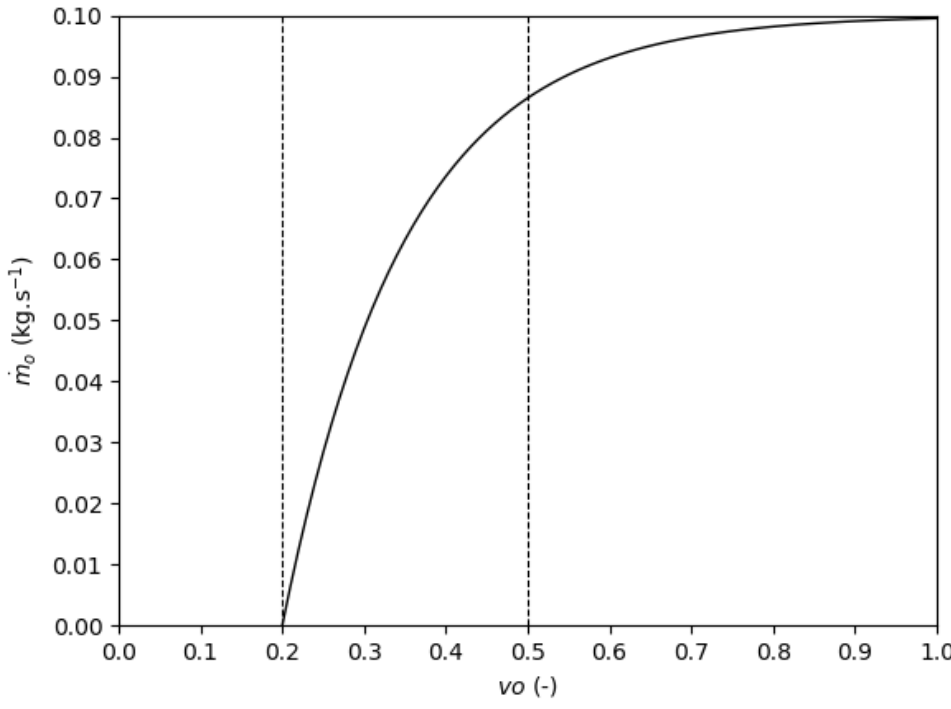
Figure 3. Mass flow rate profile in function of the valve